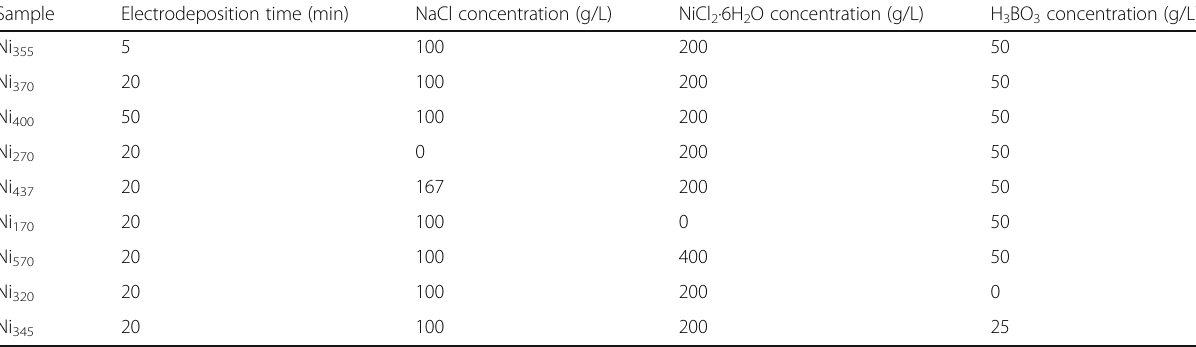
Table 1 Values of NaCl, NiCl 2 ·6H 2 O, and H 3 BO 3 concentration and electrodeposition time of different samples Sample